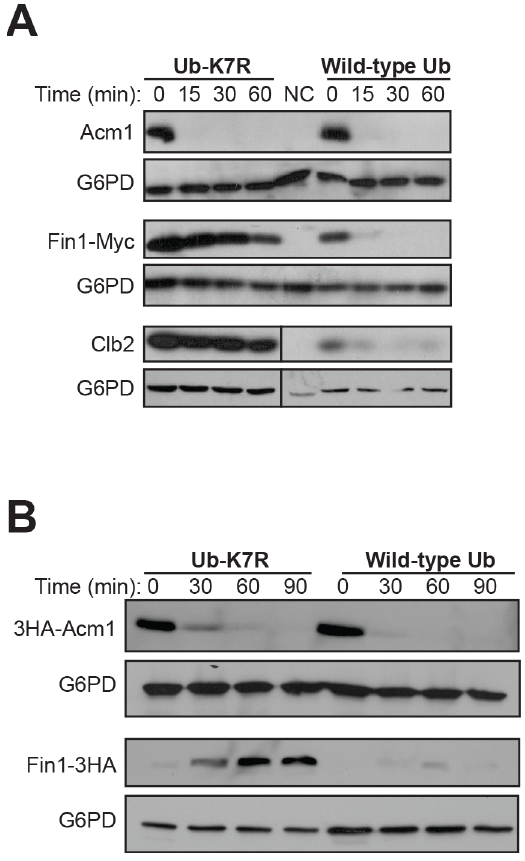
Figure 4. Acm1 proteolysis does not require assembly of polyubiquitin chains. A) YKA247 cells containing P GAL1 -driven plasmids pHLP391 (for Acm1), pESCW-Fin1-Myc, or pHLP309 (for Clb2) and P CUP1 -driven ubiquitin (Ub) overexpression plasmids LHP306 (for Ub-K7R mutant) or LHP308 (for wild-type Ub) were grown to early- exponential phase. Cells were arrested at G1 before expression of wild- type or mutant Ub was induced with 100 m M CuSO 4 and Acm1, Fin1- myc, and Clb2 with galactose. Stability of Acm1, Fin1-Myc, and Clb2 were monitored with anti-Acm1, anti-Myc, and anti-Clb2 antibodies, respectively. G6PD is a loading control. NC, negative control without galactose induction. B) The same experiment described in panel A was performed in doa4 D cells to limit the abundance of